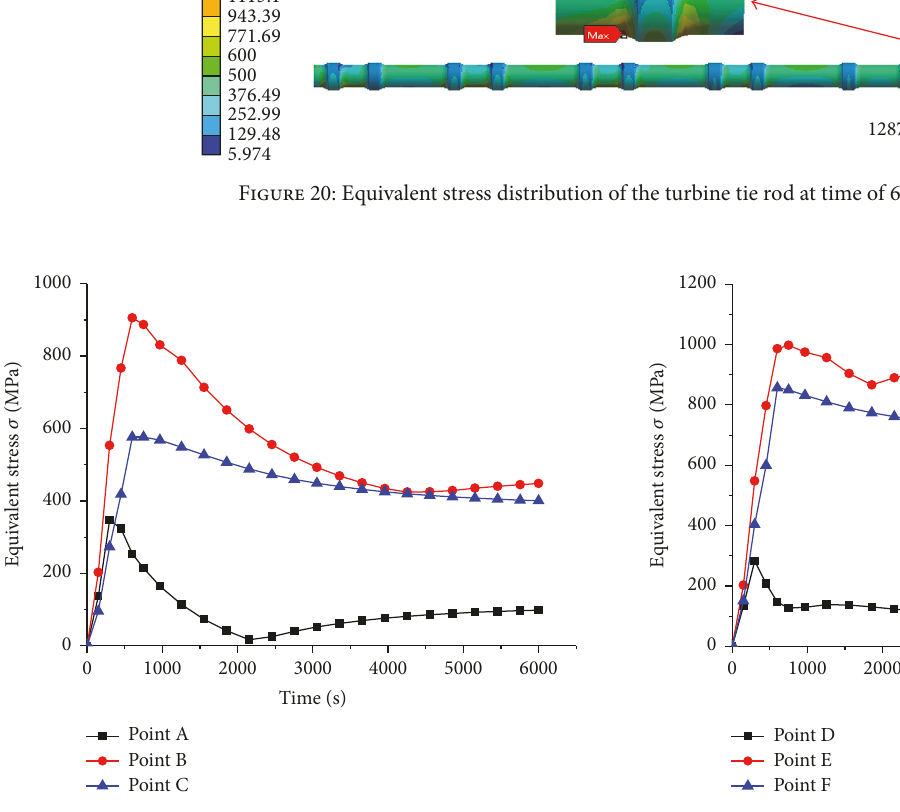
Figure 21: The equivalent stress variation of the compressor moni- toring locations during start-up period.